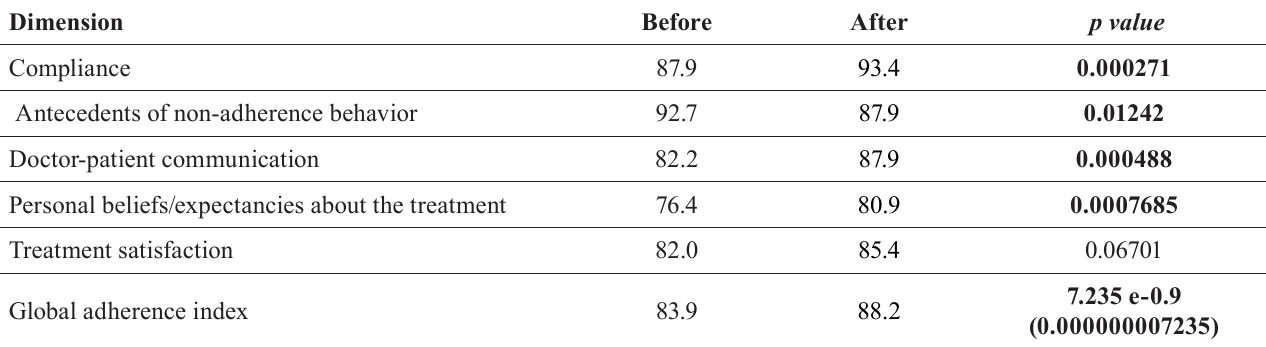
TABLE V - C omparison of means of CEAT-VIH parameters according to adherence before and after pharmaceutical monitoring